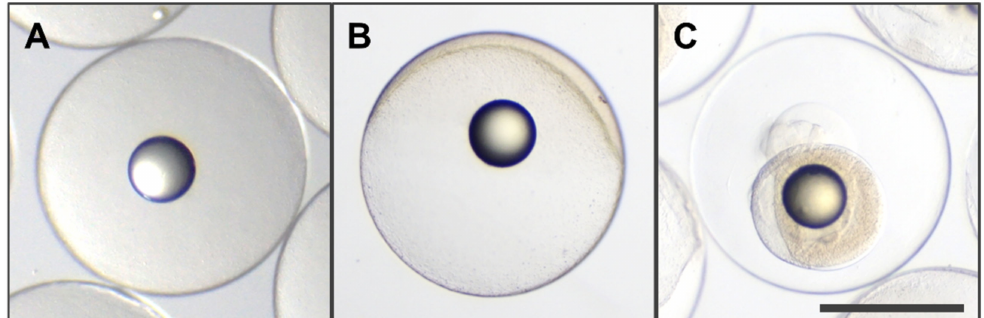
Figure 2. Ovulated eggs of kawakawa Euthynnus affinis are classified into three types by their condition after preservation. ( A ) “Clear egg” was transparent and unclouded, which was thought to retain the ability to fertilize; ( B ) “over-ripened egg” had partial discoloration and alterations in internal structure; and ( C ) “broken egg” had distorted internal structure and was clouded. “Over- ripened egg” and “broken egg” were thought to have lost their fertility. Scale bar denotes 500 µ m.